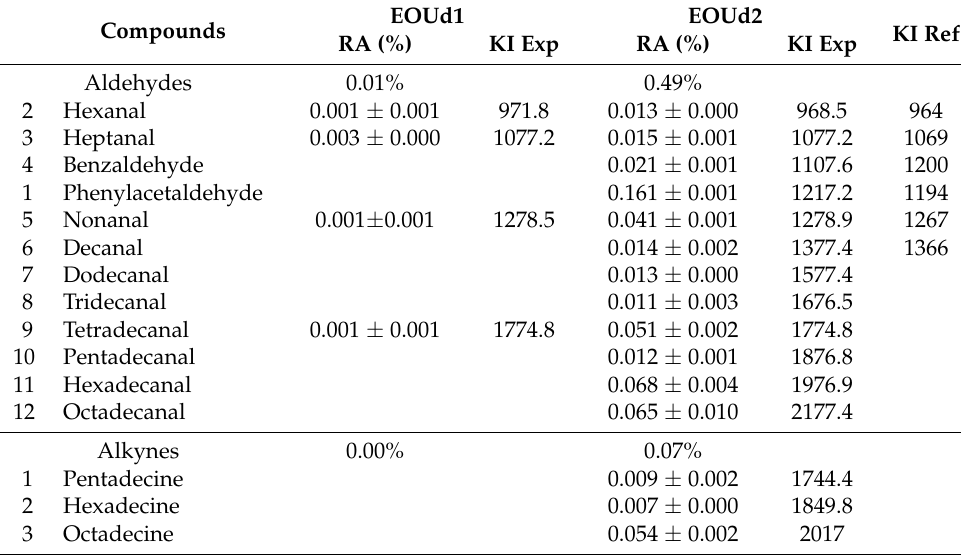
Table 5. Identified compounds of U. dermestoides essential oils derivatized by acetal and enol- ether